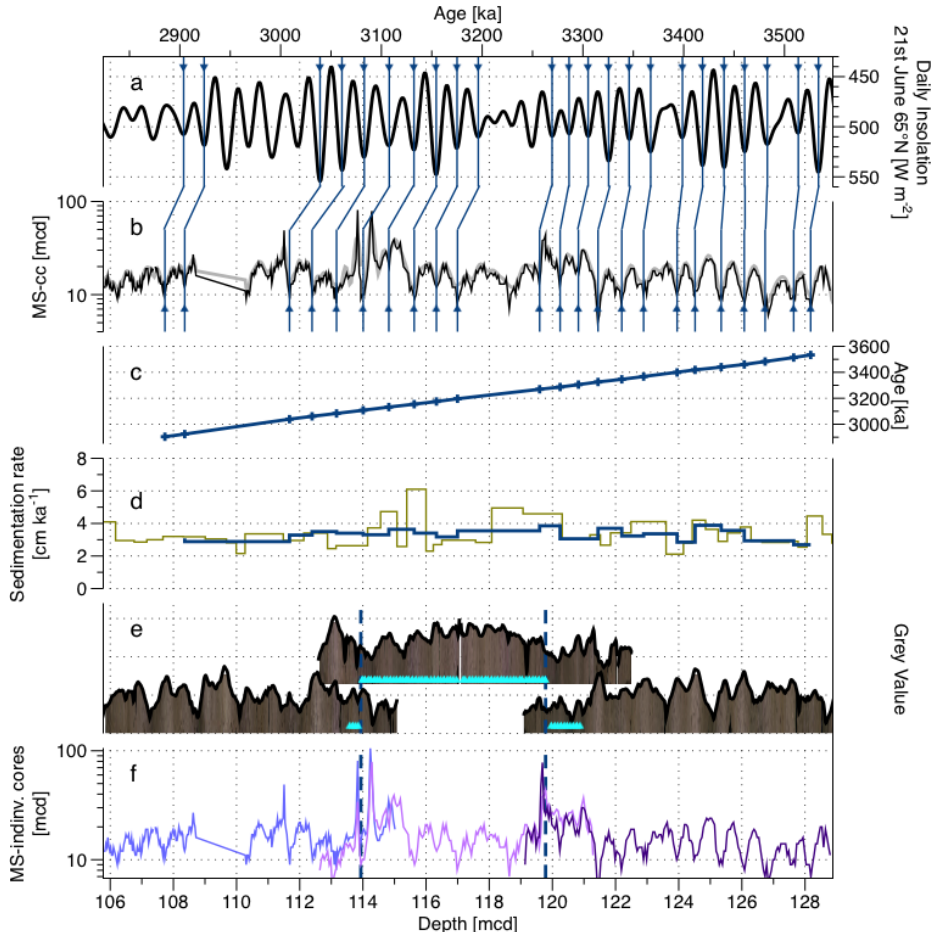
Figure 6. Depth–age correlation for the Pliocene interval across cores 154 927C 11H, 154 927A 12H and 154 927B 13H. (a) The daily insolation for 21 June at 65 ◦ N record (Laskar et al., 2004). (b) The MS record (black) and MS smoothed record (grey) according to the splice presented in this study. (c) The age–depth record with control points. (d) The SR from the Wilkens et al. (2017) age model (green) and from this study (blue). (e) The core images for the cores of the splice are from Wilkens et al. (2017) (pictures), also shown are the grey value record extracted from it (black lines), a step from one core to the other in the splice (dashed lines), and the position of the samples used in this study in the cores (light blue triangles). (f) MS record for the individual cores (Curry et al., 1995; Wilkens et al., 2017) and steps from one core to the other in the splice (dashed